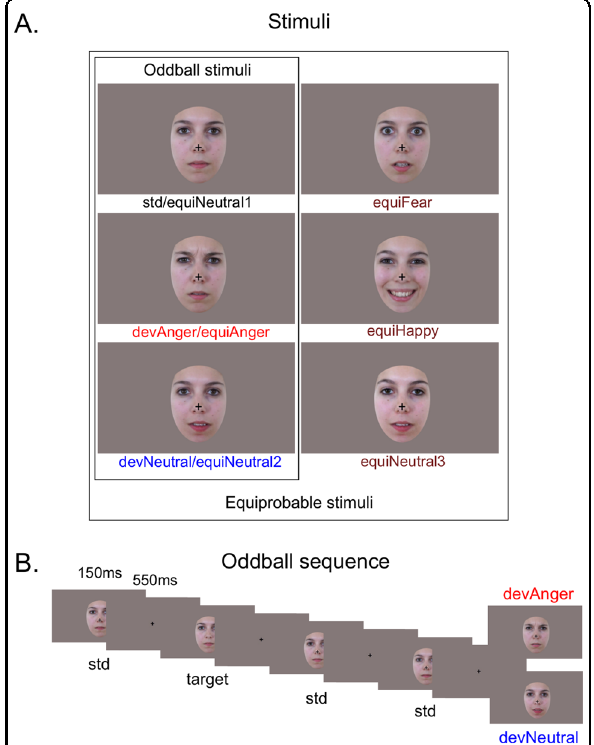
Fig. 1 Stimuli and example of oddbal sequence. A Illustration of the stimuli used in the oddball sequence ( N = 3) and in the equiprobable sequence ( N = 6). B Example of the oddball sequence showing the time course of the task. Stimuli were presented for 150 ms, followed by the central cross presented for 550ms (SOA = 700 ms). Target consisted of a standard face stimulus with no cross (participants had to detect the disappearance of the central